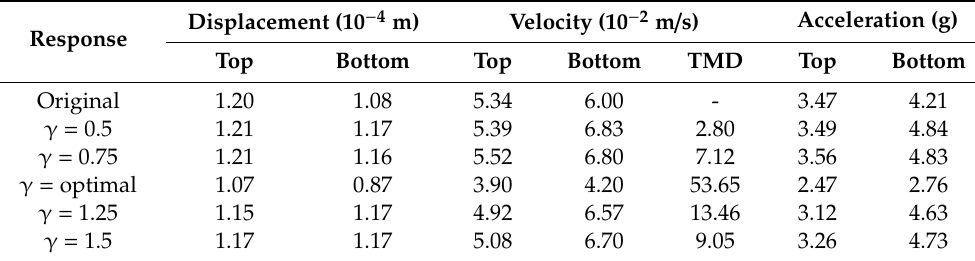
Table 4. Structural responses with different tuning frequency ratios.